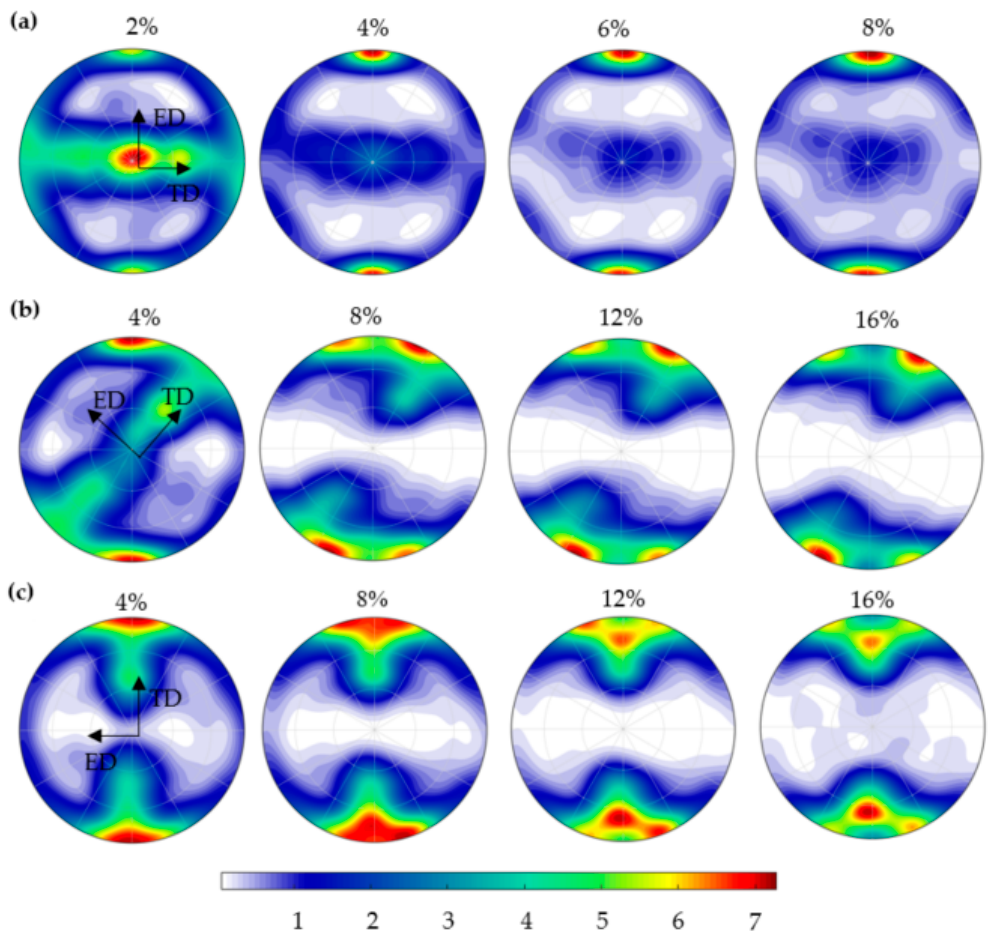
Figure 6. Predicted texture evolution of {0001} pole figure under uniaxial compression to different strain levels of ( a ) E0; ( b ) E45; ( c ) E90.